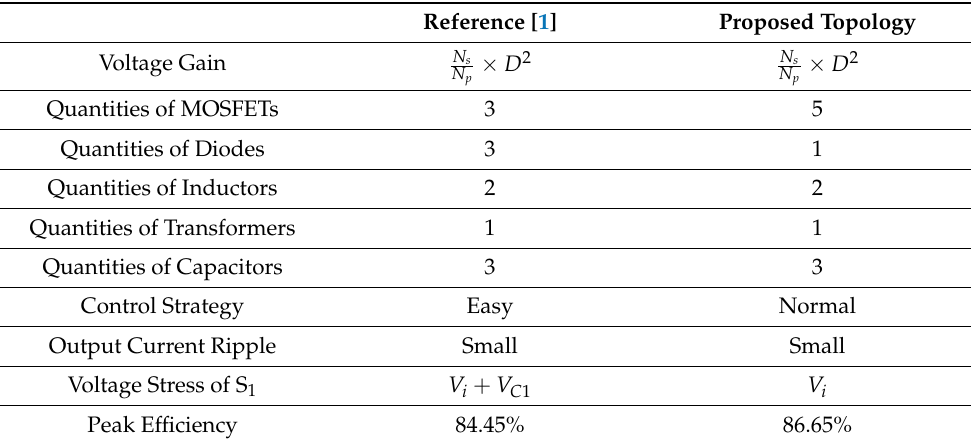
Table 3. Performance comparison between Ref. [1] and the proposed